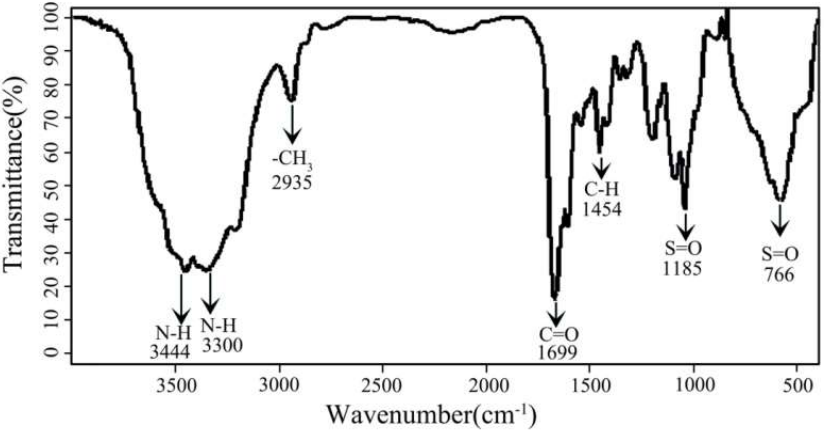
Figure 2. FT−IR spectrum of quadripolymer (AM/AMPS/DMDAAC/SSS).